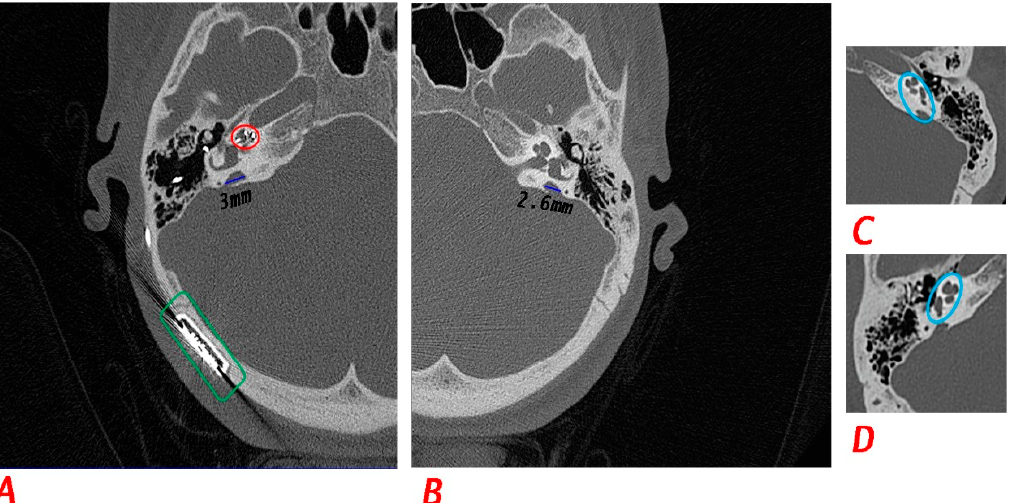
Figure 4. Temporal CT scan findings for F1: IV-3 and F1: IV-4. ( A , B ) Axial view of bilateral temporal bone CT scan for F1: IV-4 at the age of 17 years old post cochlear implantation where the blue lines represent the length of the EVA. The red circle shows the electrodes of the cochlear implant and the green rectangle shows the implanted cochlear device ( A ) for the right side and ( B ) for the left side. ( B , C ) Axial view of bilateral temporal bone CT scan for F1: IV-3 at the age of 25 years old showing features of incomplete partition II (Mondini Deformity) indicated by the blue circle ( C ) for the left side and ( D ) for the right side.